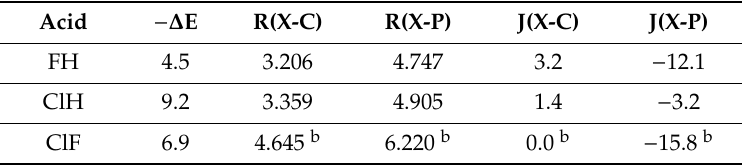
Figure 6. Equilibrium structures C for ( a ) FH:P(CH) 3 , ( b ) ClH:P(CH) 3 , and ( c ) FCl:P(CH) 3 . Table 4. Binding energies ( − ∆ E, kJ mol − 1 ), intermolecular distances (R, Å), and spin–spin coupling constants (J, Hz) for complexes XY:P(CH) 3 isomers C a .